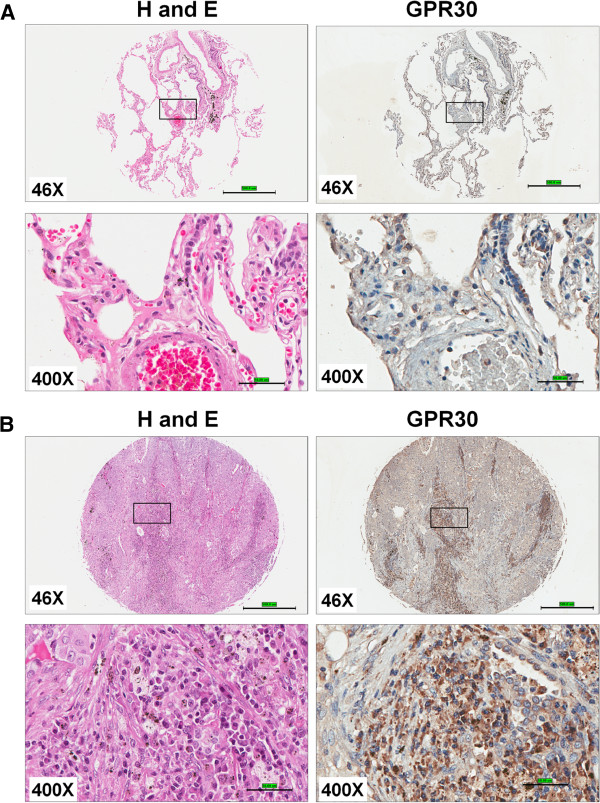
GPER/GPR30 expression in human lung tumors. The TMA slides were stained with H&E and anti-GPR30. The representative tissue spots/cores for normal (A) and squamous cell carcinoma (B) are shown. The left panels represent H and E staining of normal lung (A) and squamous cell carcinoma (B) and right panels representGPR30 IHC staining at 46X (scale bar 500 μm) and 400X (scale bar 50 μm) magnification The images were collected using Aperio imagescope.